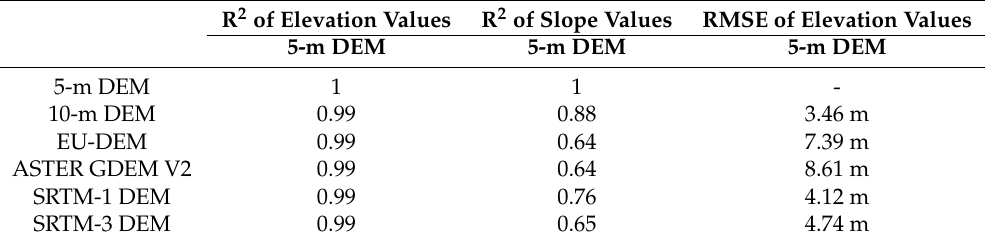
Table 6. Correlations of the elevation and slope value rasters between the 5-m reference DEM and the other DEMs. RMSE of the elevation relative to the 5-m reference